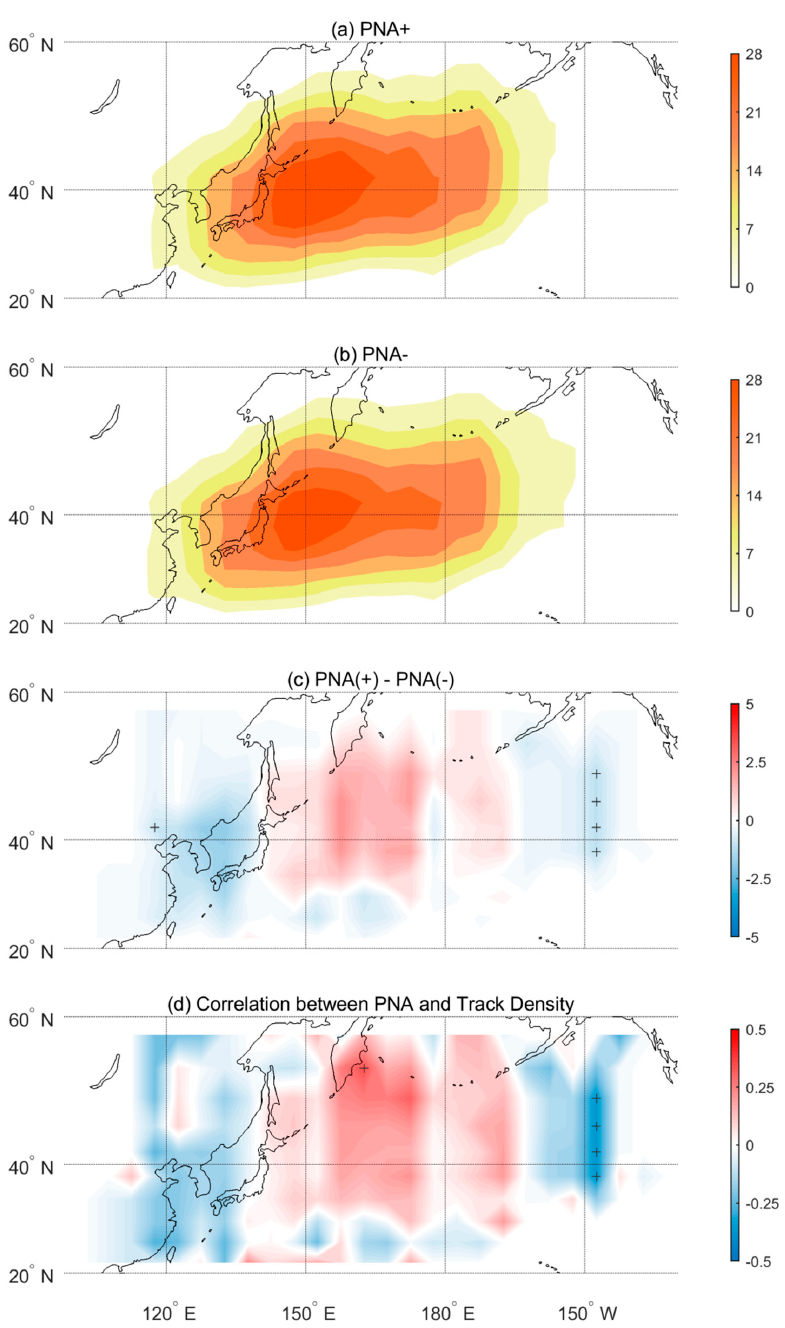
Figure 5. ( a , b ) Composite of the ETC track density in the positive and negative phases of PNA over the Northwest Pacific in wintertime from 1979 to 2018, Unit: cyclones per winter per grid. ( c ) The difference in ETC density between the positive and negative phases of PNA. ( d ) Correlations between the PNA index and ETC track density. Grids with values statistically significant at the 95% level are indicated by the symbol “+”.